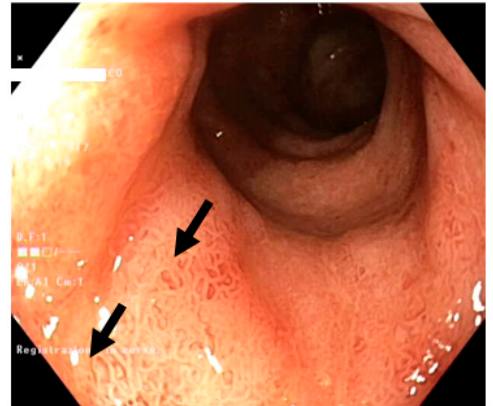
Figure 2. Erosions in the context of the hyperemic colonic mucosa (black arrows): superficial mucosal breaks within the hyperemic surrounding mucosa.